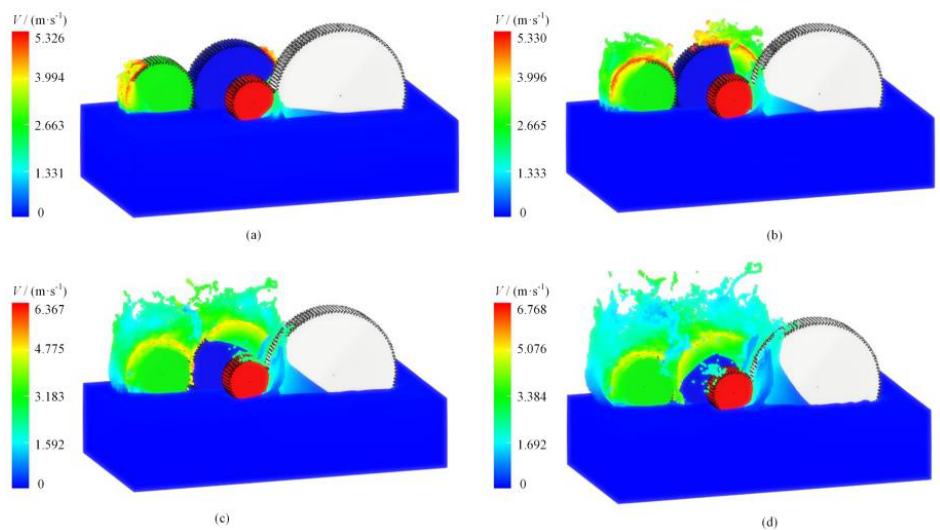
Figure 3. The dynamic evolution process of the lubrication flow field. ( a ) t = 0.02 s; ( b ) t = 0.04 s; ( c ) t = 0.06 s; ( d ) t = 0.08 s.